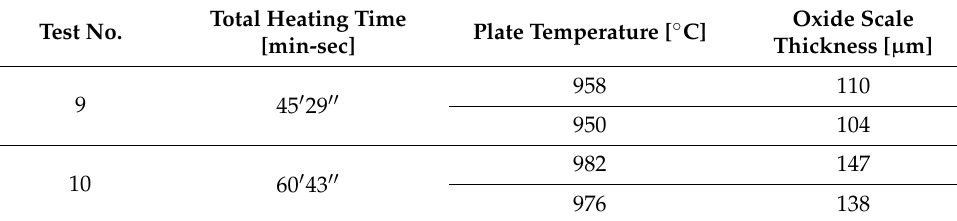
Figure 15. Graphs of cooling in test No. 5. The notations are the same as in Figure 14.